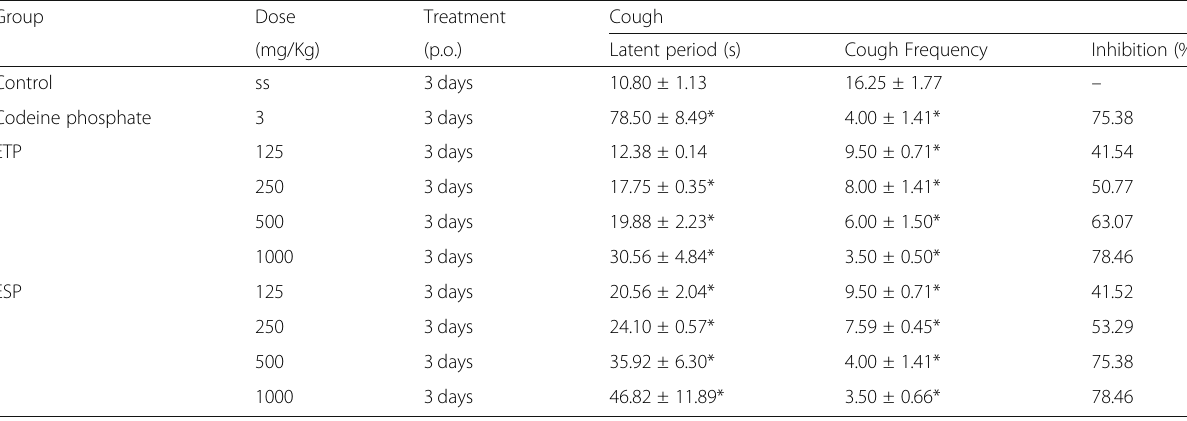
Table 3 Effects of ethanol extracts of propolis of T. fiebrigi (ETP) and S. jujuyensis (ESP) on the ammonia liquor-induced cough in rats Group